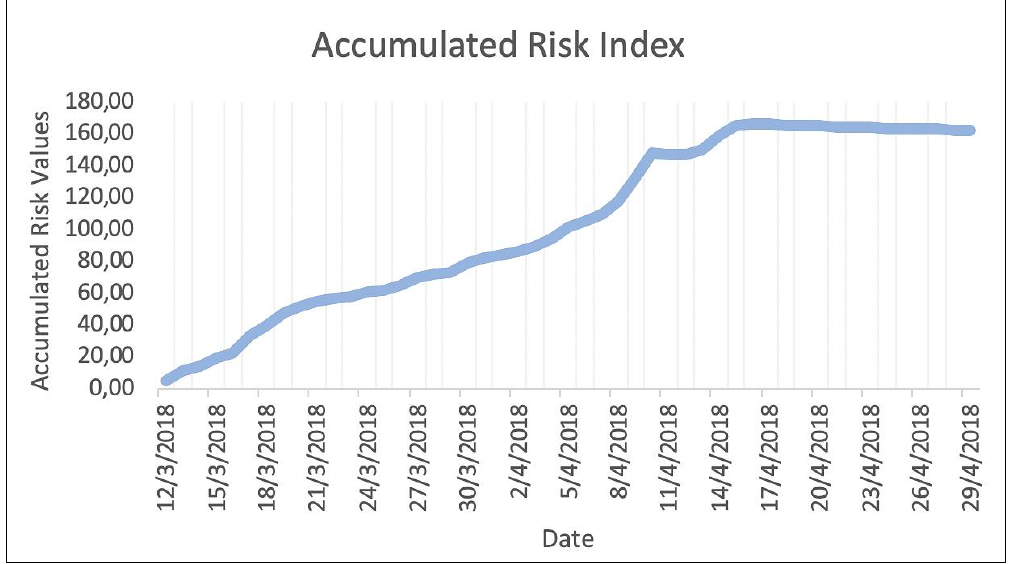
Figure 2. Accumulated risk recorded from 12/03/2018 to